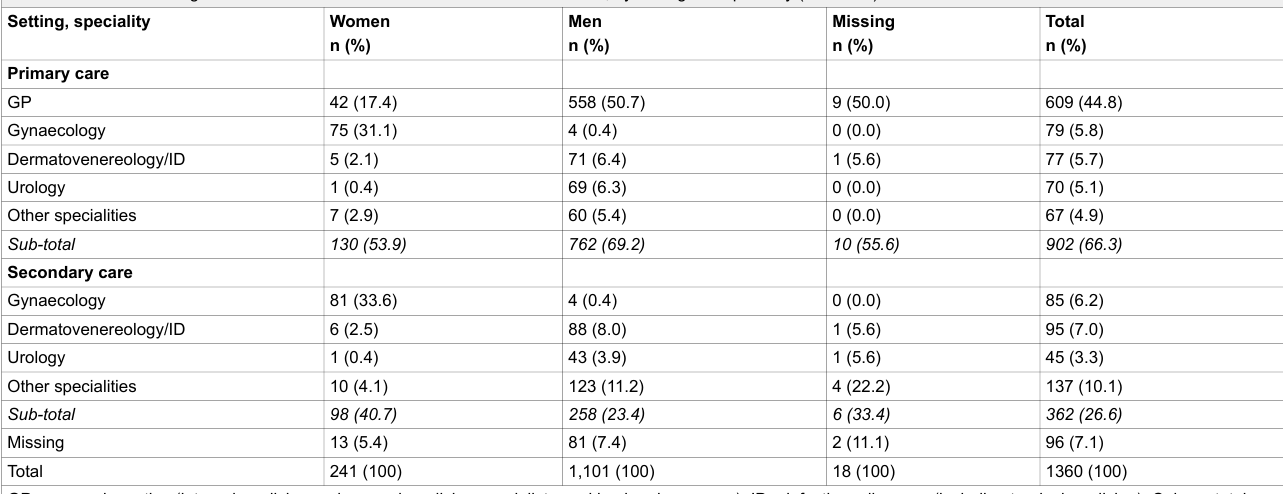
Table 2: Notifications of gonorrhoea in women and men 01.01.2007–30.11.2008, by setting and speciality (N =